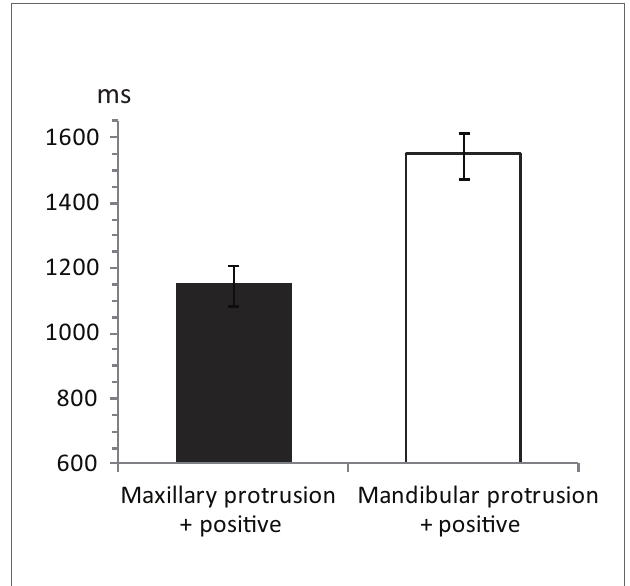
FIGURE 3 | Mean response times in the IAT for 24 participants. Mean response time for the condition of maxillary-protrusion photographs + positive words (mandibular-protrusion + negative) is shown as dark gray bar, whereas for the condition of mandibular-protrusion photographs + positive words (maxillary protrusion + negative) is shown as white bar. The error bars indicate the